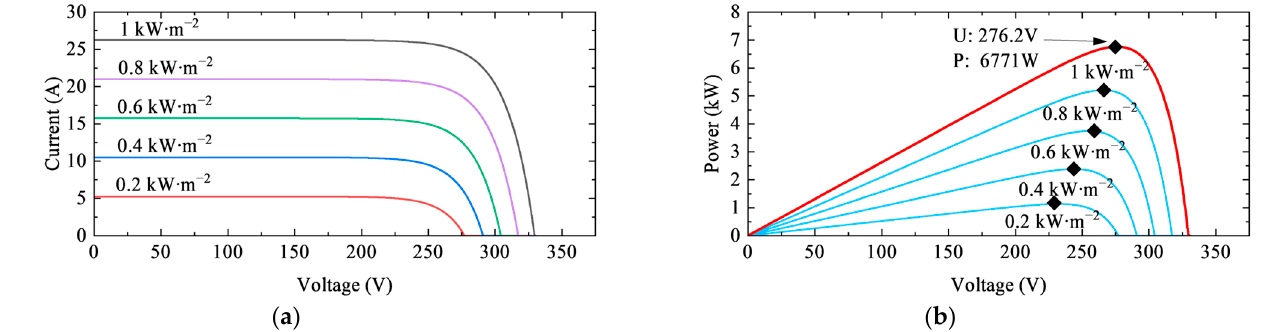
Figure 2. Electrical characteristics of PV array at 25 °C. ( a ) Current versus voltage curve under dif- ferent radiation; ( b ) power versus voltage curve under different radiation.